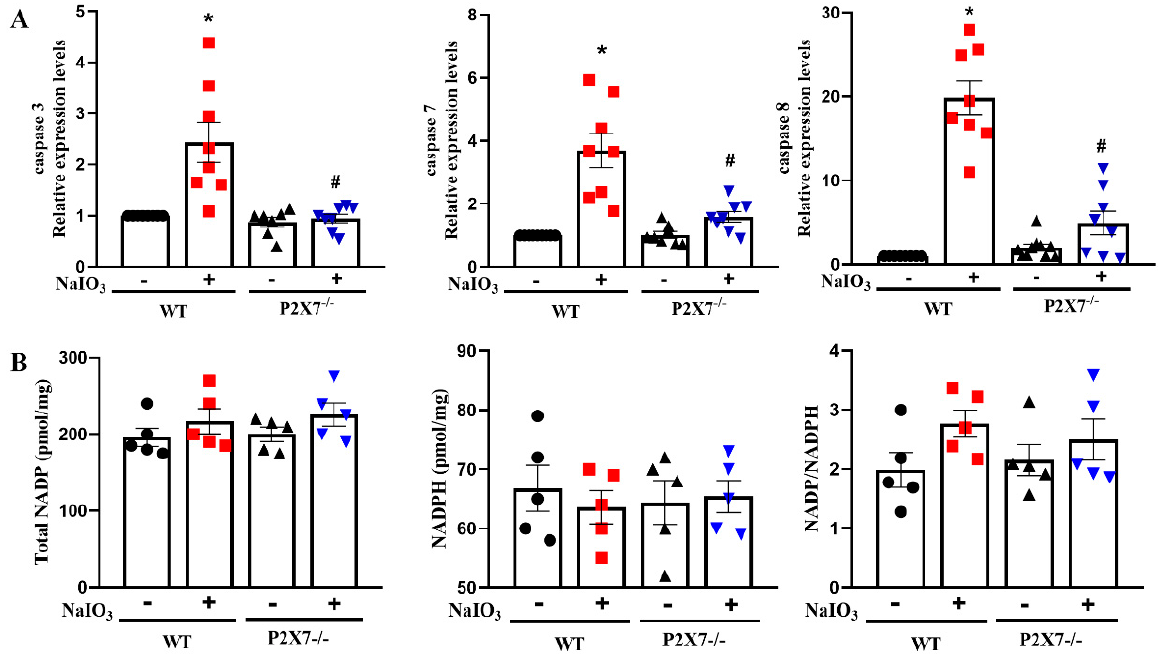
Figure 6. NaIO 3 -induced caspase expression in retina was reversed by P2X7 knockout . ( A ) After 3 days post-injection of NaIO 3 (25 mg/kg), mice retina was collected, and total mRNA was extracted and reversely transcribed for quantitative PCR analyses of caspase-3, caspase-7 and caspase-8 mRNA expression. The mice number for qPCR analysis was 5 for each group. Values were normalized to β -actin gene expression and were expressed relative to the control group. ( B ) Using the retinal tissues to measure the cellular contents of total NADP, NADPH and NADP/NADPH as per manufacturer’s instructions. The mice number for NADPH activity was 5 for each group. * p < 0.05 compared with the WT control group, # p < 0.05 compared with the WT control group treated with NaIO 3 .